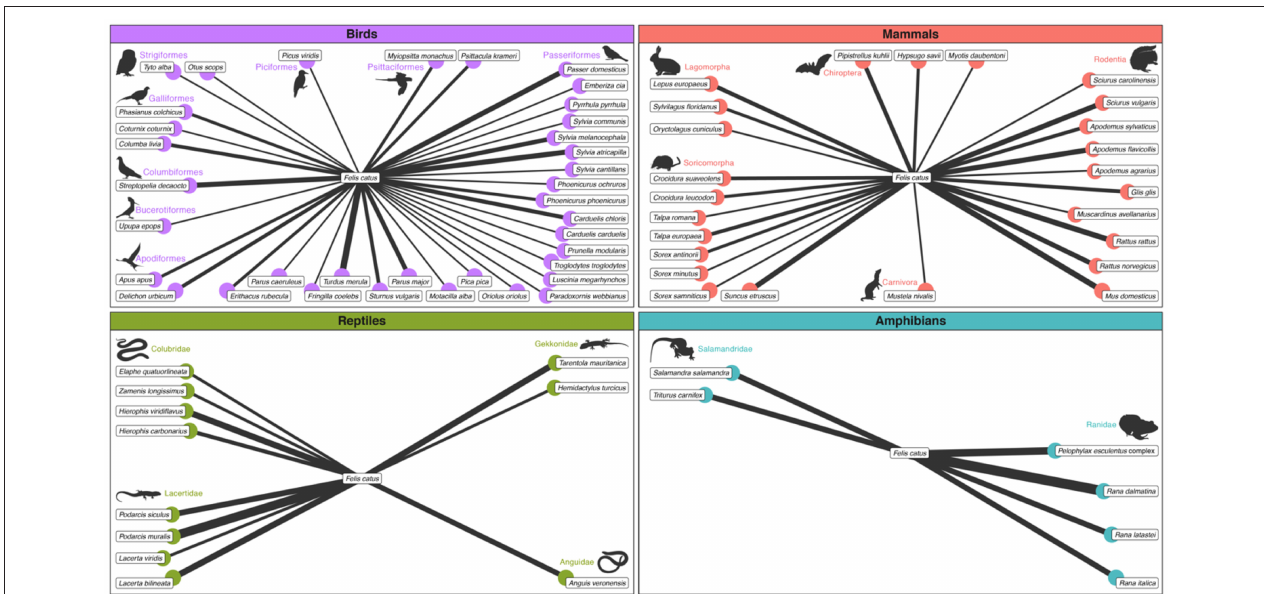
FIGURE 3 | Reported killings of 21 domestic cats for the following groups of vertebrates: birds, mammals, reptiles, and amphibians. The thickness of black lines represents the proportion of individuals of each killed species within each taxonomical class.